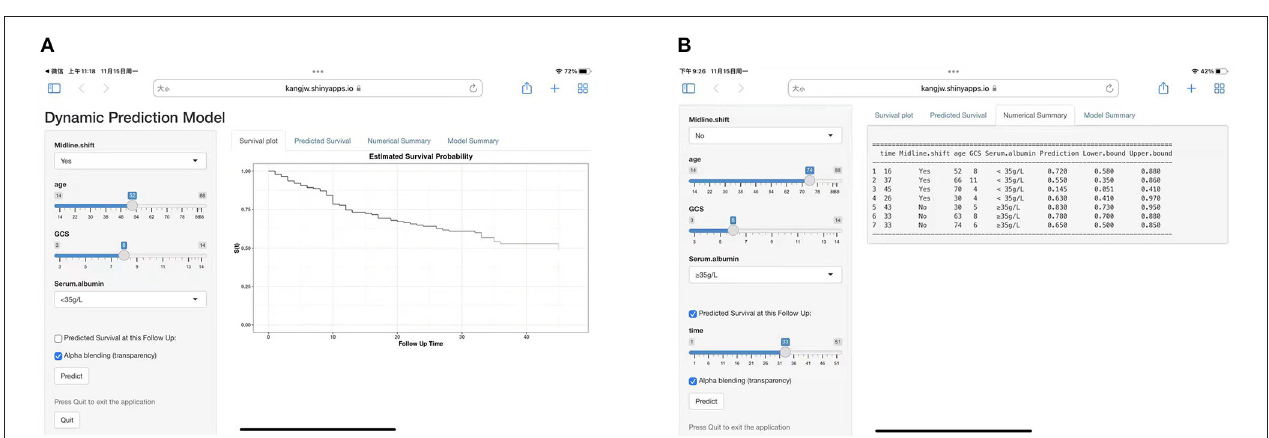
FIGURE 2 | A clinical feature model was used to develop a nomogram.